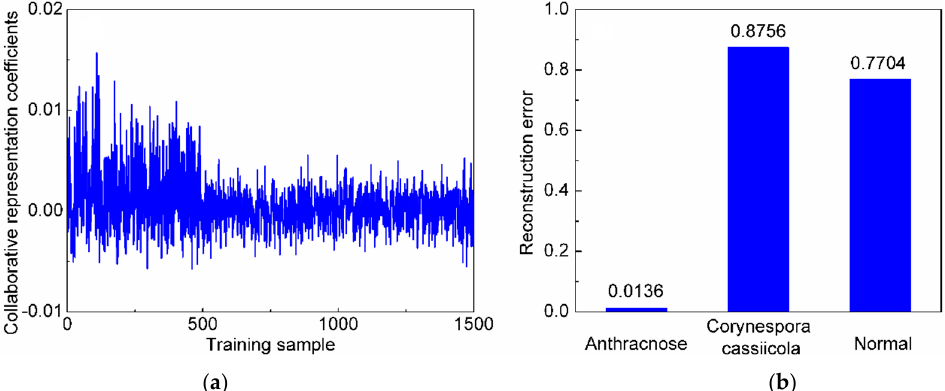
Figure 7. ( a ) The collaborative representation coe ffi cients of a query sample from the first class; ( b ) the Figure 7. (a) The collaborative representation coefficients of a query sample from the first class; ( b ) the reconstruction residuals corresponding to each reconstruction residuals corresponding to each disease.